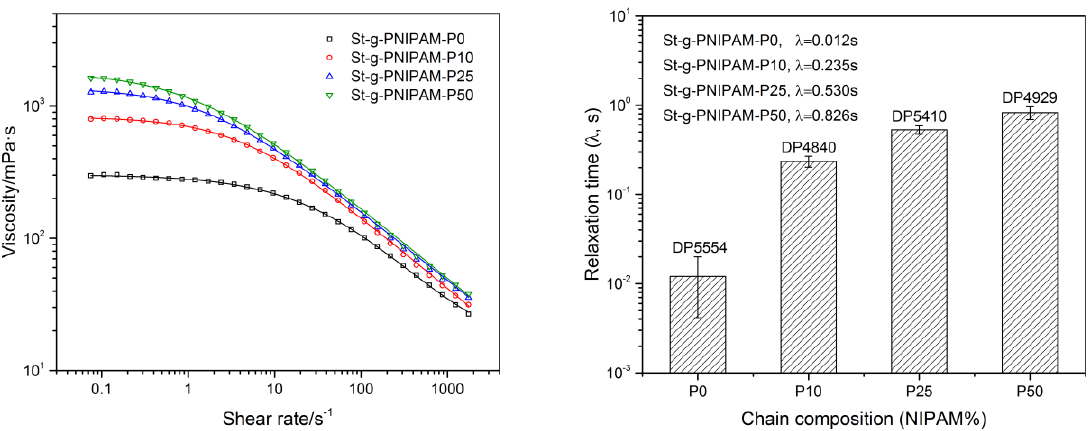
Figure 3. Viscosity as a function of shear rate ( Left , 1.2 wt % copolymer solution) and corresponding relaxation time from the “Carreau–Yasuda” model ( Right ).